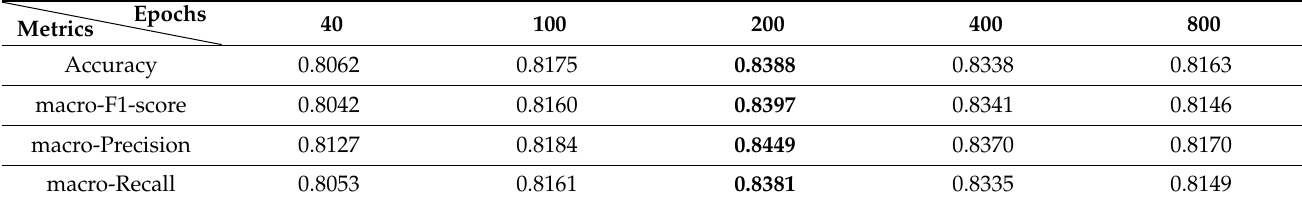
Table 3. The classification performance of models with different pre-training epochs when the number of BERT layers is eight and sample size is